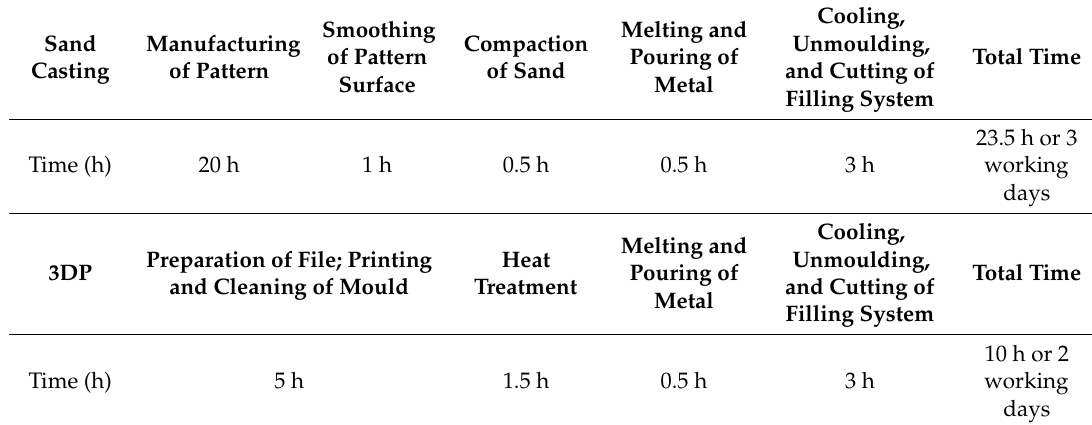
Table 4. Time taken for each manufacturing stage.